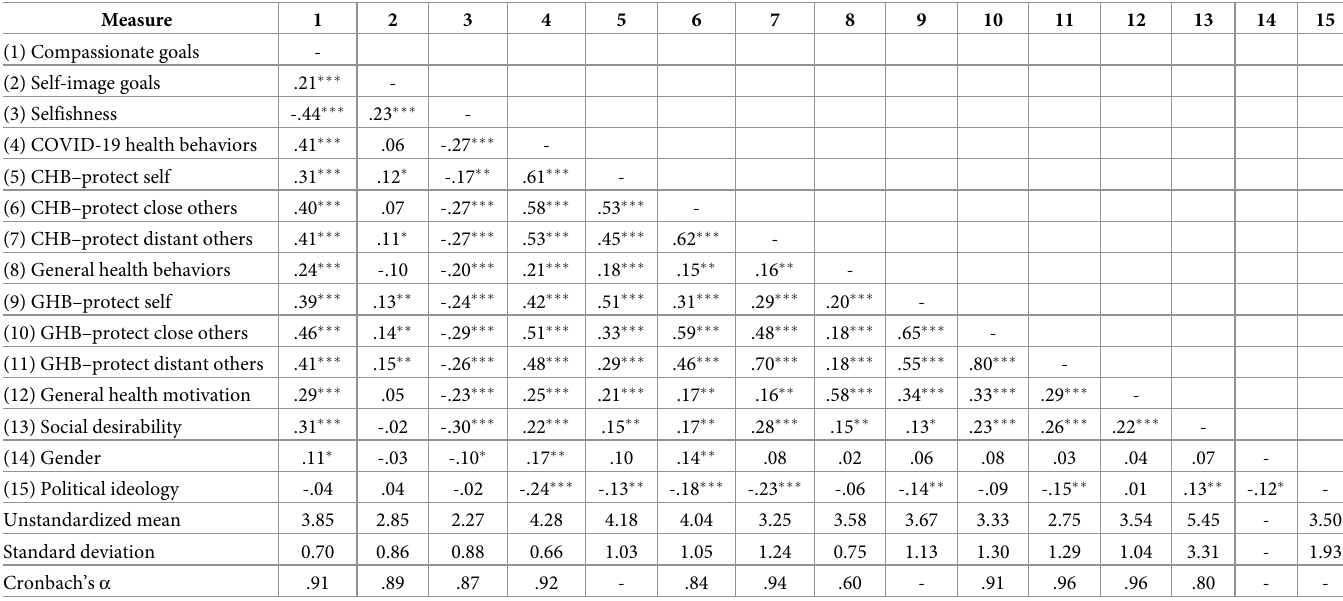
Table 5. Descriptive statistics and zero-order correlations in Study 2.